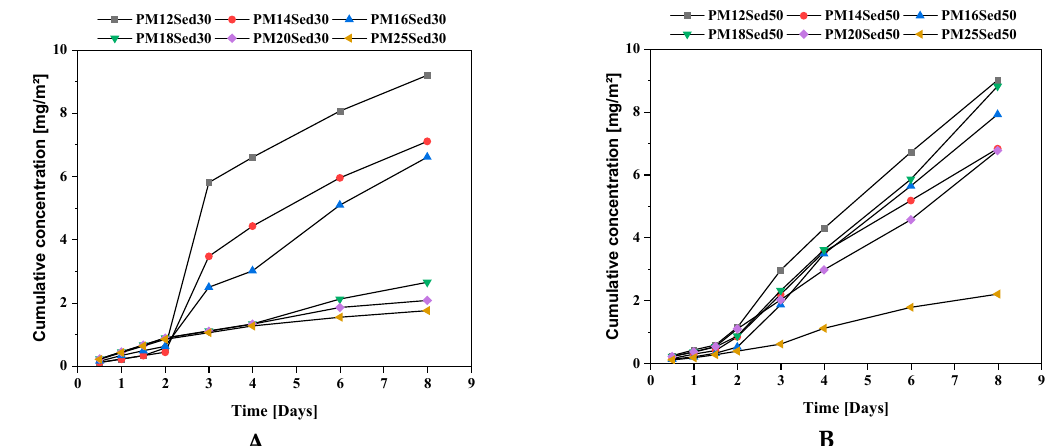
Figure 10. Evolution of the cumulative concentration of Barium in leachates from monolithic polymer mortars containing 30% ( A ) and 50% ( B ) of sediments in their matrices .